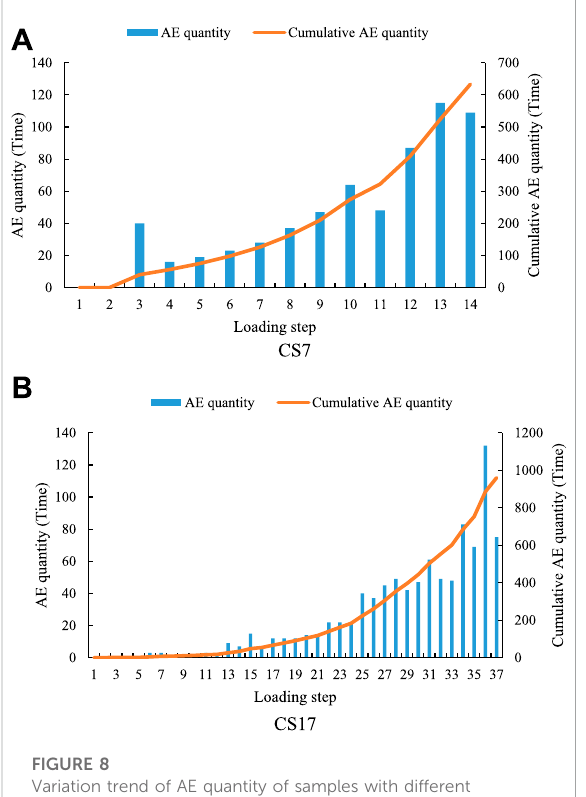
FIGURE 8 Variation trend of AE quantity of samples with different strength under the same lower boundary water pressure. FIGURE 9